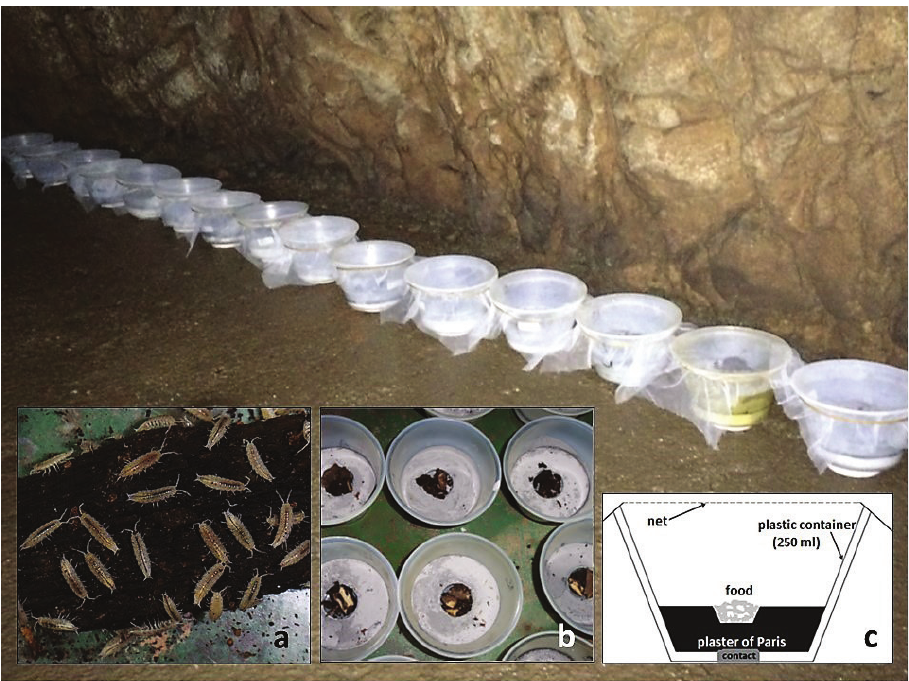
Figure 2. Microcosm model populations in the Baradla cave (north-eastern Hungary). a Mesoniscus graniger individuals aggregating on decaying wood b plan view of a microcosm container with food in the middle c schematic cross section of a